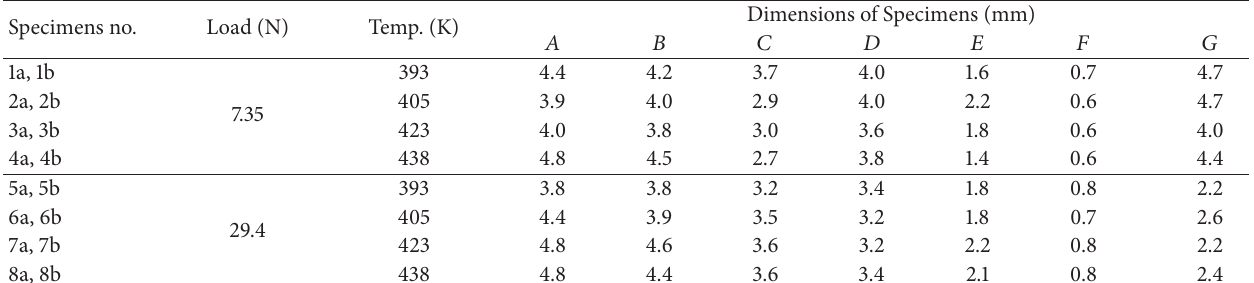
Figure1:Creepexperimentsetupandspecimensarrangement:(a)tensilecreepspecimen,(b)shearcreepspecimen,and(c)creepexperiment setup. Table 1: Creep specimen